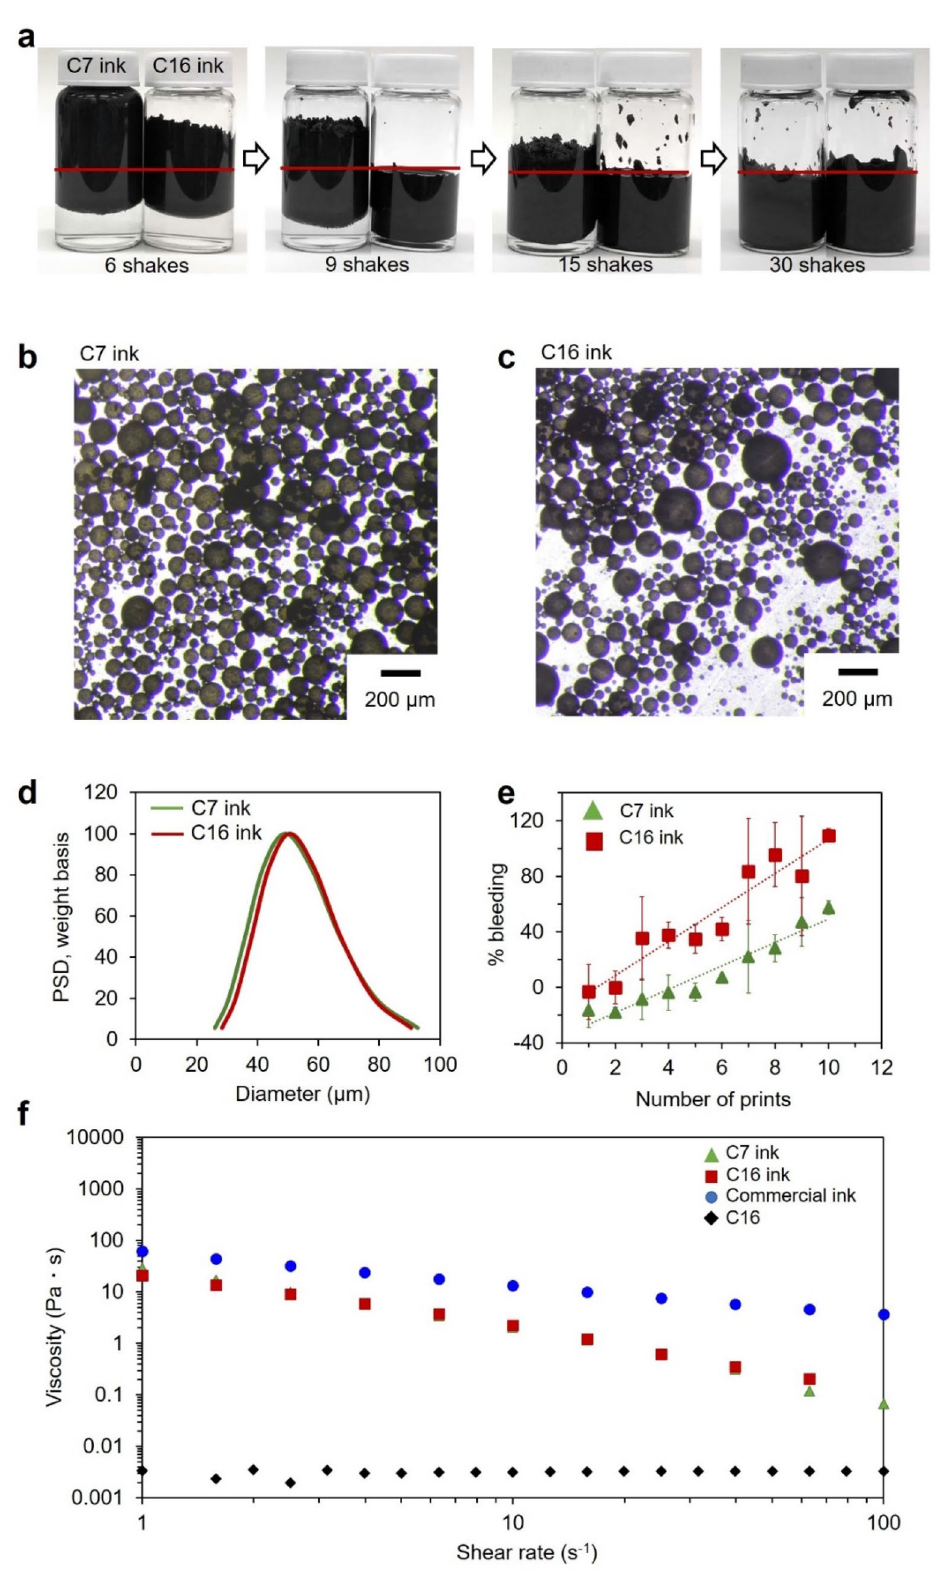
Figure 3. ( a ) Graphene stabilized emulsion forms faster with C16 as compared to C7. (red line indicates the liquid/air interface, C7 represents heptane, C16 represents hexadecane); ( b ) optical microscopy image of C7 ink; ( c ) optical microscopy image of C16 ink showing water droplets to be approximately the same size as seen with C7 in ( b ); ( d ) acoustic spectroscopy results showing similar size and size distribution of C7 and C16 inks; ( e ) plot comparing the line resolution with number of prints for C7 and C16 inks. The error bars are the standard error calculated from a minimum of three measurements for each data point: ( f ) viscosity of C7 and C16 ink at different shear rates, with a comparison to a commercial screen-printing ink and pure